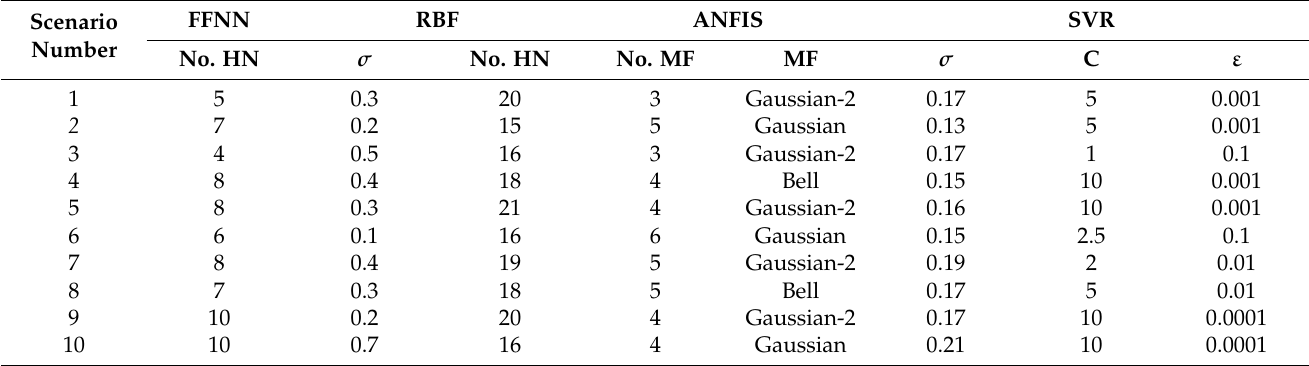
Table 4. Optimal structure of FFNN, RBF, ANFIS, and SVR models for different inputs 2